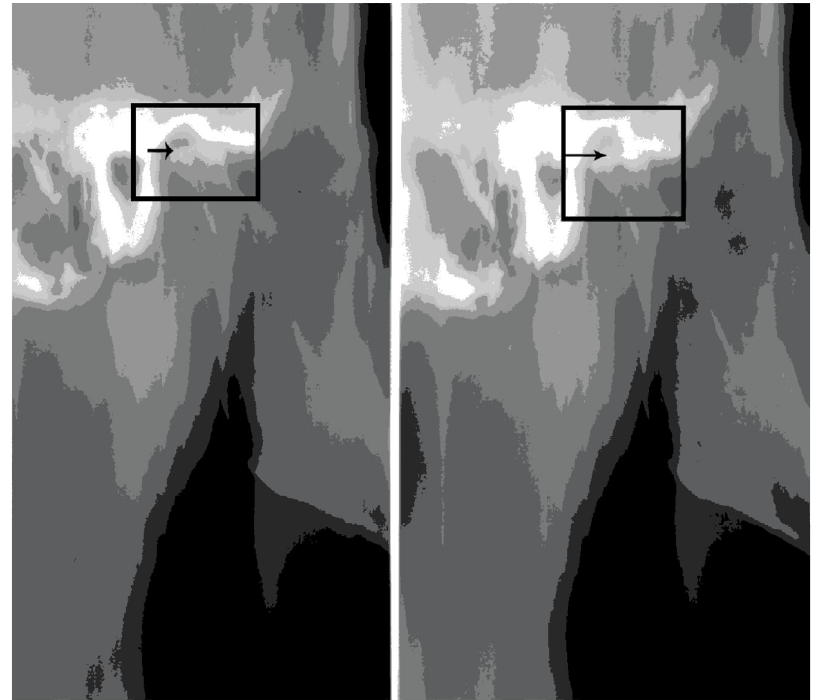
Figure 3: Stratigraphy of right TMJ. The arrows indicate the erosive changes on the surface of the condyle with interruption of cortical lining. When the articular eminence and the condyles are in contact, the joint space is narrow. Condyles and articular eminence appear both fl